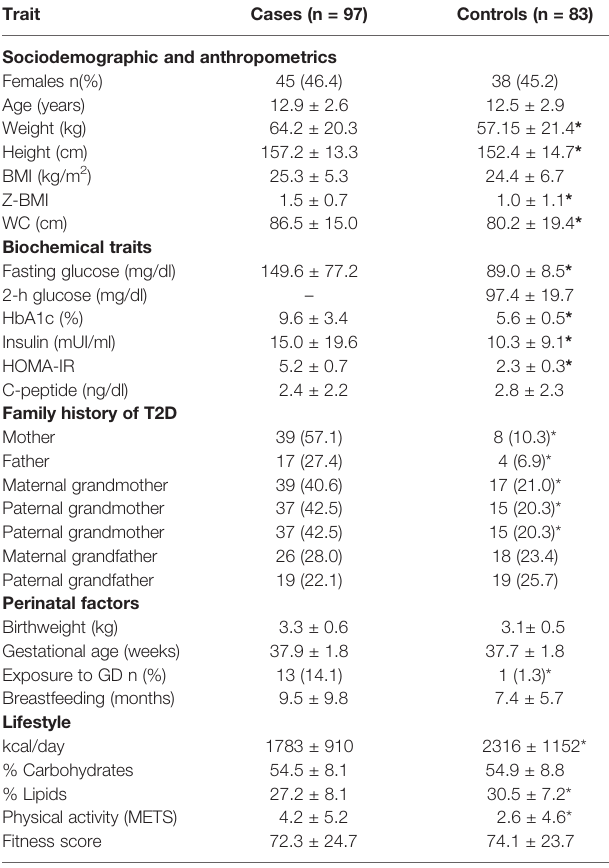
TABLE 2 | Clinical characteristics of cases and controls.